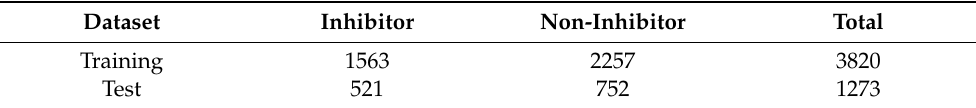
Table 1. Training and test datasets used in our